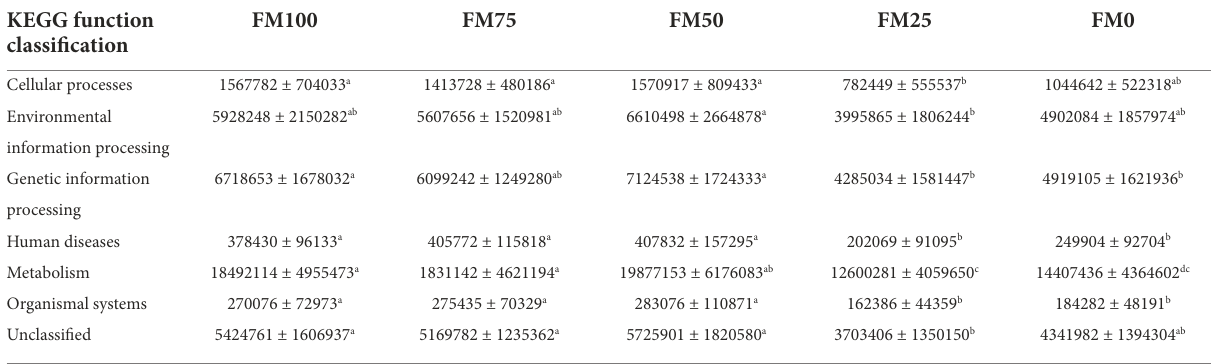
TABLE 3 KEGG function prediction of the gut microbial communities from largemouth bass fed with different levels of Chlorella meal diets. FM100 represents the fishmeal diet without Chlorella meal; FM75, FM50, FM25, and FM0 represent the fishmeal diet with 25, 50, 75, and 100% fishmeal replacement by Chlorella meal, respectively. The values represent the numbers of predicted functional genes of gut microbial communities. Different letters within the same row indicate significant